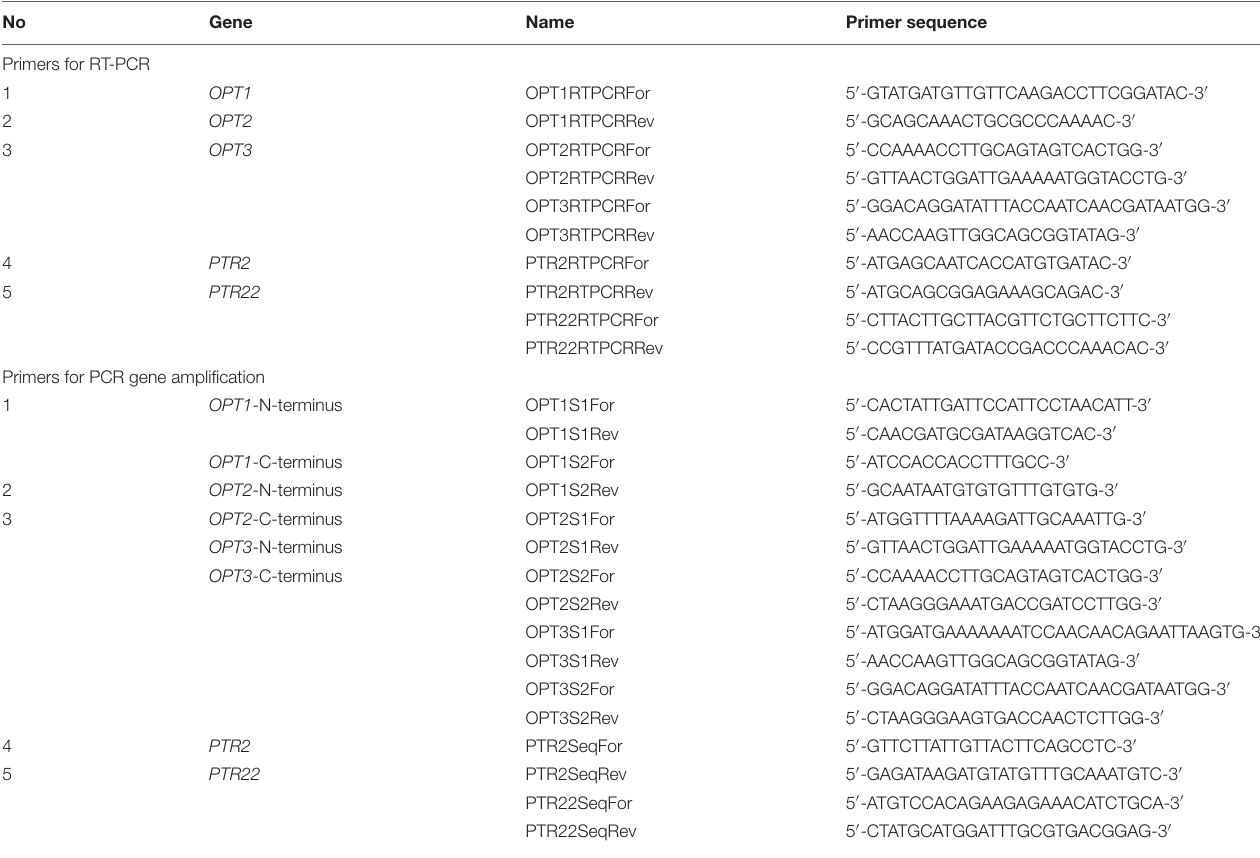
TABLE 2 | Primers used for RT-PCR and in PCR gene amplification for